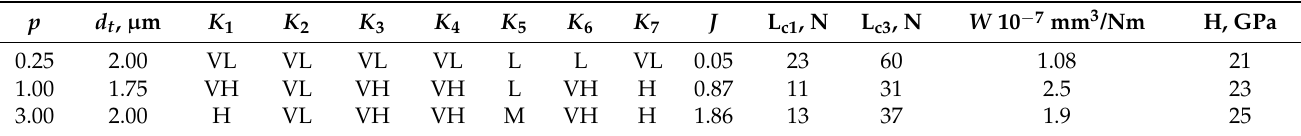
Table 2. Summary of numerical simulations and experimental tests of selected